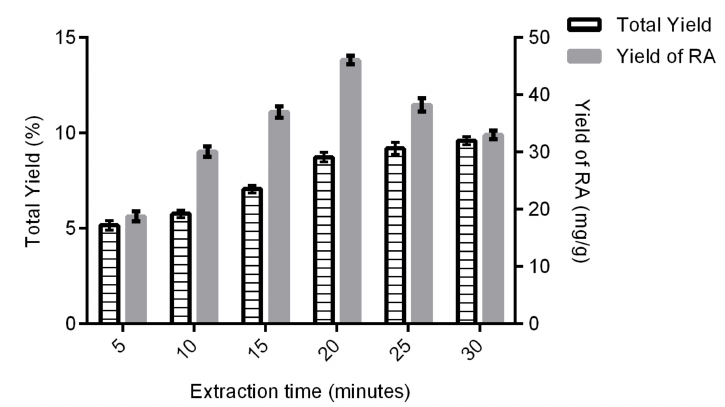
Figure 1. E ff ect of extraction time on total yield and yield of rosmarinic acid (RA). Data were generated from three experiments ( n = 3) and presented as mean with standard deviation as error